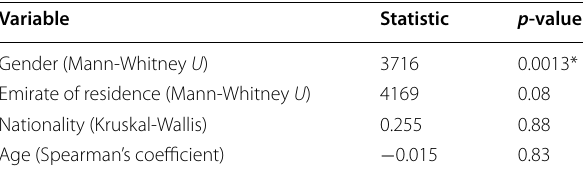
Table 3 Demographic associations of family values scale